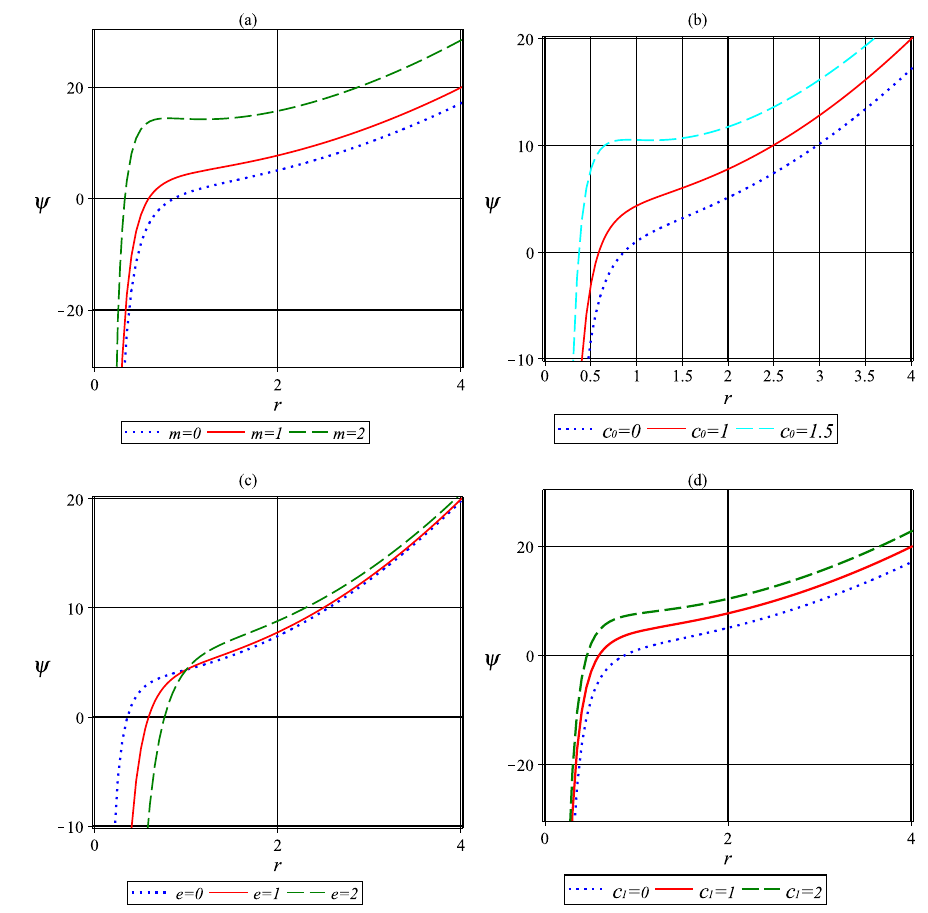
Fig. 1 Horizon structure for unit values of the model